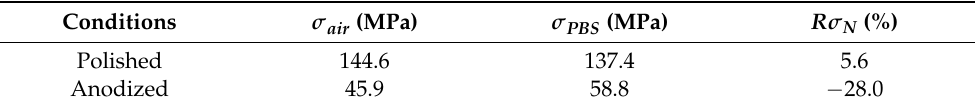
Table 4. Reduction rate of the maximum applied stress for the AZ31B alloy in the polished and anodized